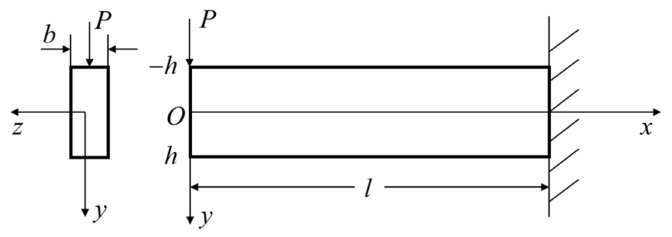
Figure 1. Decagonal quasicrystal cantilever